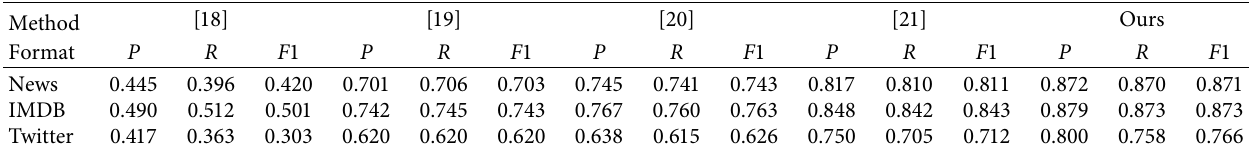
Table 2: The results of embedded rate estimation